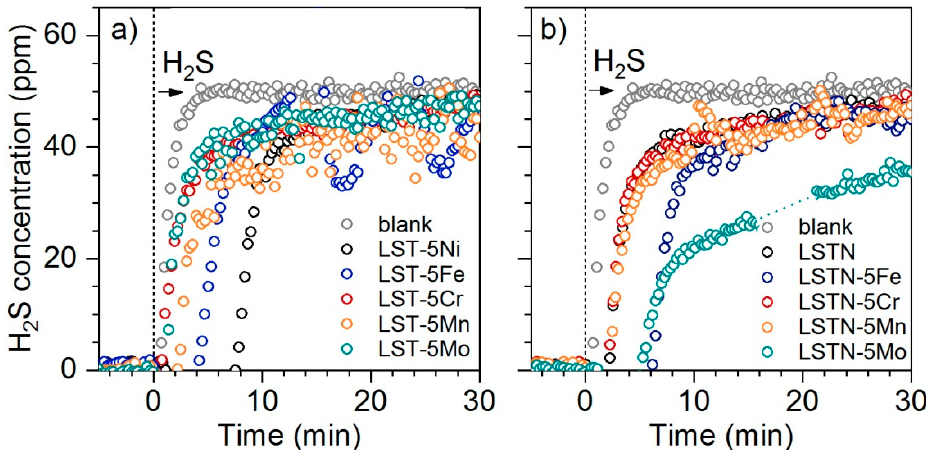
Figure 4. H 2 S breakthrough curves during H 2 S adsorption experiments on reduced ( a ) LST-5Me (Me = Mo, Mn, Cr, Fe, Ni) and ( b ) LSTN-5Me (Me = Mo, Mn, Cr and Fe). The start time of sulfur addition is indicated by the vertical dashed line.